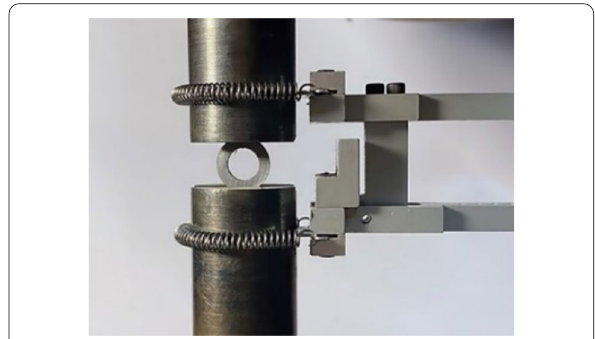
Figure 10 RCT set-up